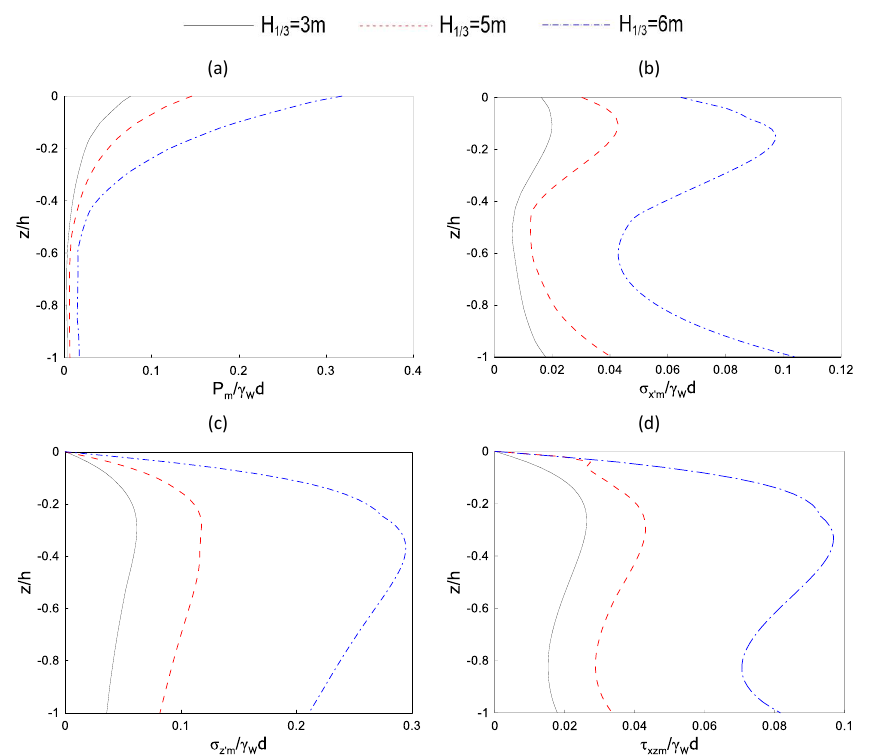
Figure 21. Distribution of the maximum soil response under the random wave with various wave heights. ( a ) pore-water pressures ( p m / γ w d ); ( b ) horizontal effective normal stress ( σ (cid:48) xm / γ w d ); ( c ) vertical effective normal stress ( σ (cid:48) zm / γ w d ); and ( d ) shear stress ( τ xzm / γ w d